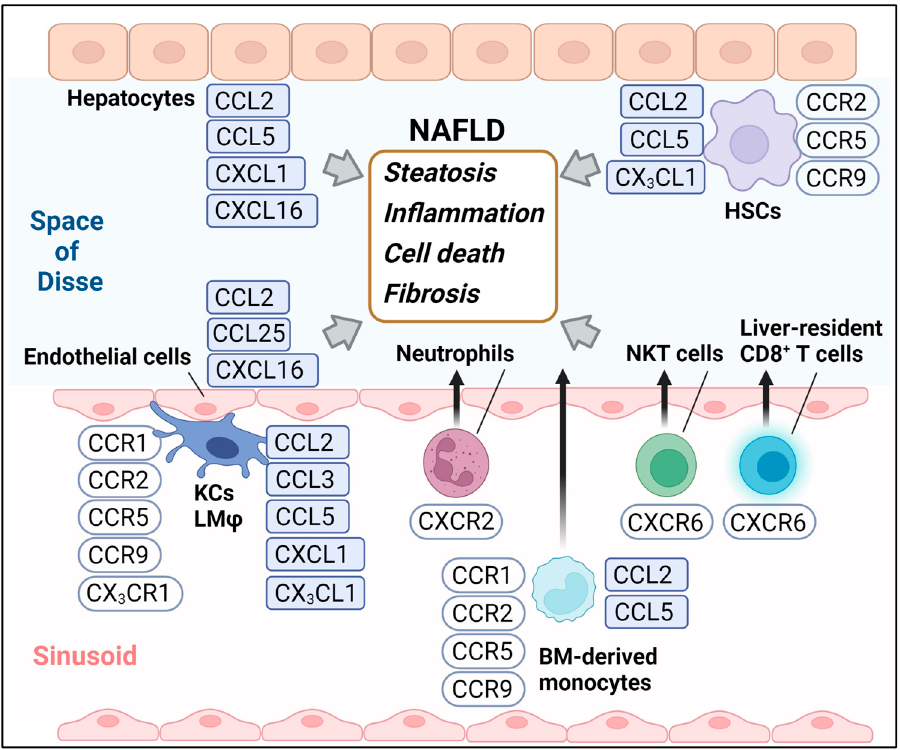
Figure 1. The chemokines and chemokine receptors highlighted in this review. BM, Bone marrow; KCs, Kupffer cells; LM φ , Liver macrophages; HSCs, Hepatic stellate cells.